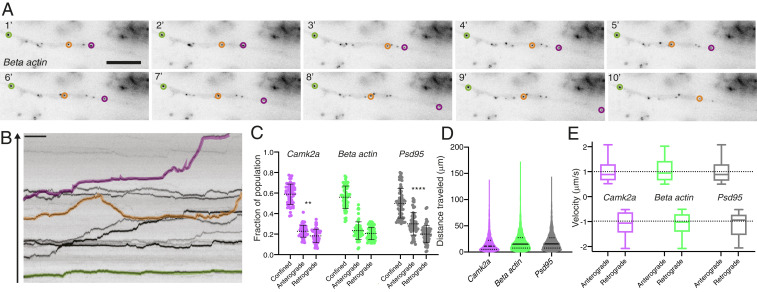
Tracking and classifying mRNA dynamics along dendrites in live neurons. (A) Still images from a β-actin Atto647N-labeled dendrite (Movie S6), shown are single frames every minute for 10 min (of 20 total). Individual mRNA puncta are highlighted to illustrate distinct dynamic profiles, mainly stationary (green) or confined with periods of motility (orange and magenta). (Scale bar, 5 μm.) (B) Kymograph from the first 10 min of (Movie S6). Arrow denotes the anterograde direction along the dendrite. (Scale bar, 1 min.) (C) Quantification of mRNA dynamic state: confined, anterograde vs. retrograde for Atto565 Camk2a, Atto565 β-actin, and Atto565 Psd95. n = 59 cells. **P < 0.01, ****P < 0.0001 Holm–Sidak’s multiple comparison test. (D) Quantification of cumulative distance traveled for Atto565 Camk2a, Atto565 β-actin, and Atto565 Psd95. n = 59 cells. (E) Quantification of mRNA velocity for anterograde and retrograde for Atto565 Camk2a (1.013 ± 0.450; −1.083 ± 0.480), Atto565 β-actin (1.054 ± 0.493; −1.110 ± 0.452), and Atto565 Psd95 (0.997 ± 0.426; −1.111 ± 0.479). n = 59 cells.